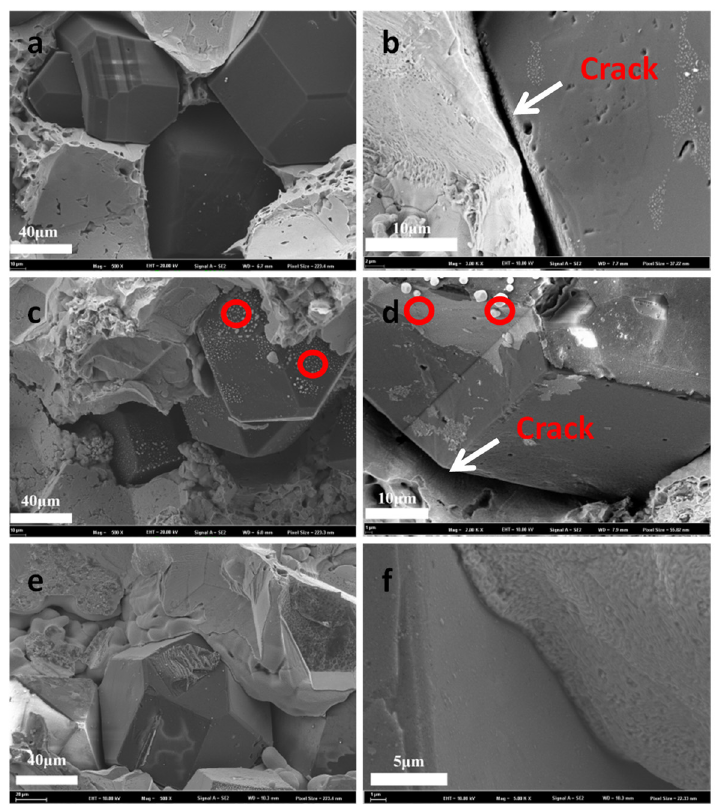
Figure 4. Fracture morphologies of the 40 vol.% Cu/diamond composites fabricated at 1243 K based on ( a , b ) uncoated diamond particles; ( c , d ) Cu-coated diamond particles; ( e , f ) Ti-coated diamond particles.